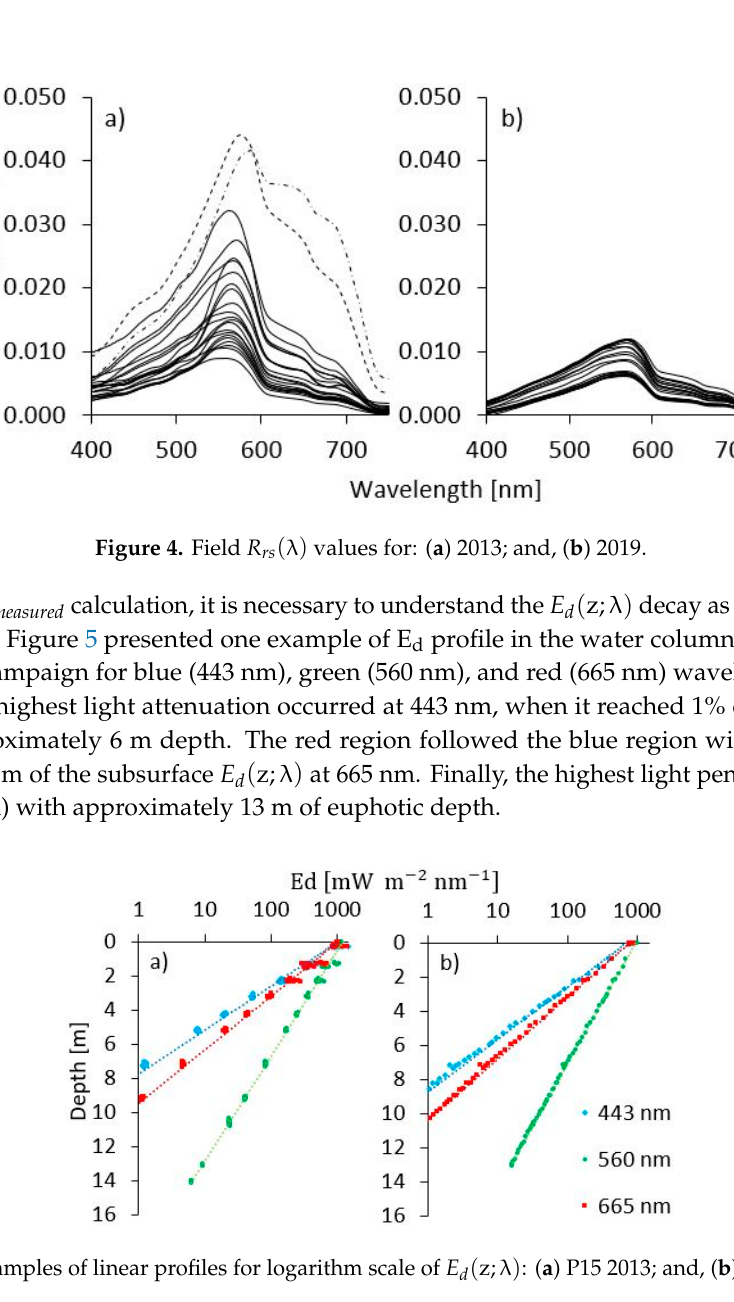
Figure 5. Examples of linear profiles for logarithm scale of 𝐸 (cid:3031) (z; λ) : ( a ) P15 2013; and, ( b ) TRM09 2019.